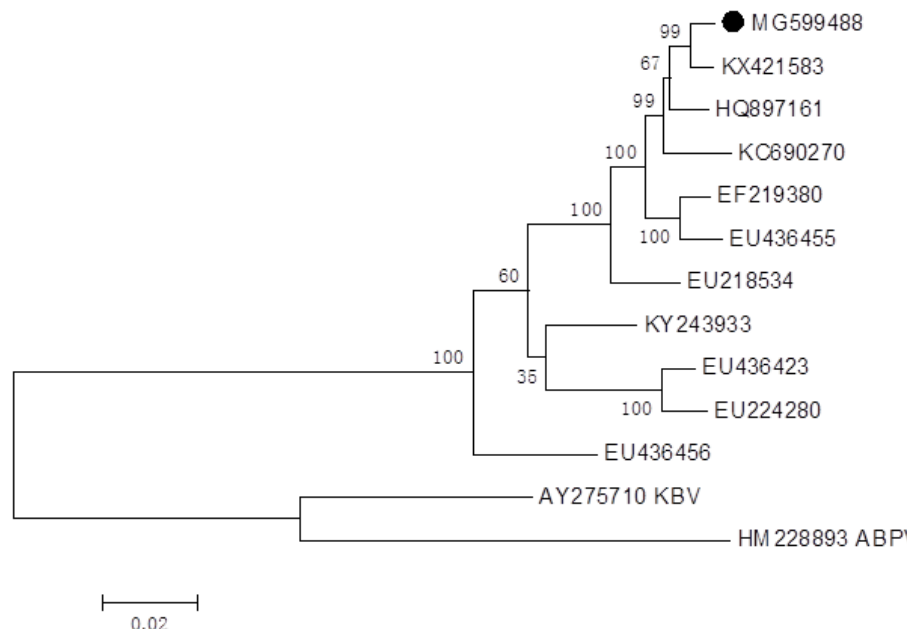
Figure 2. Phylogenetic analysis of the infectious clone sequence of IAPV. The black dot indicates the obtained IAPV in the current study (Number MG599488). Bootstrap values are indicated on each node as a result of the 1000 replicates calculated.